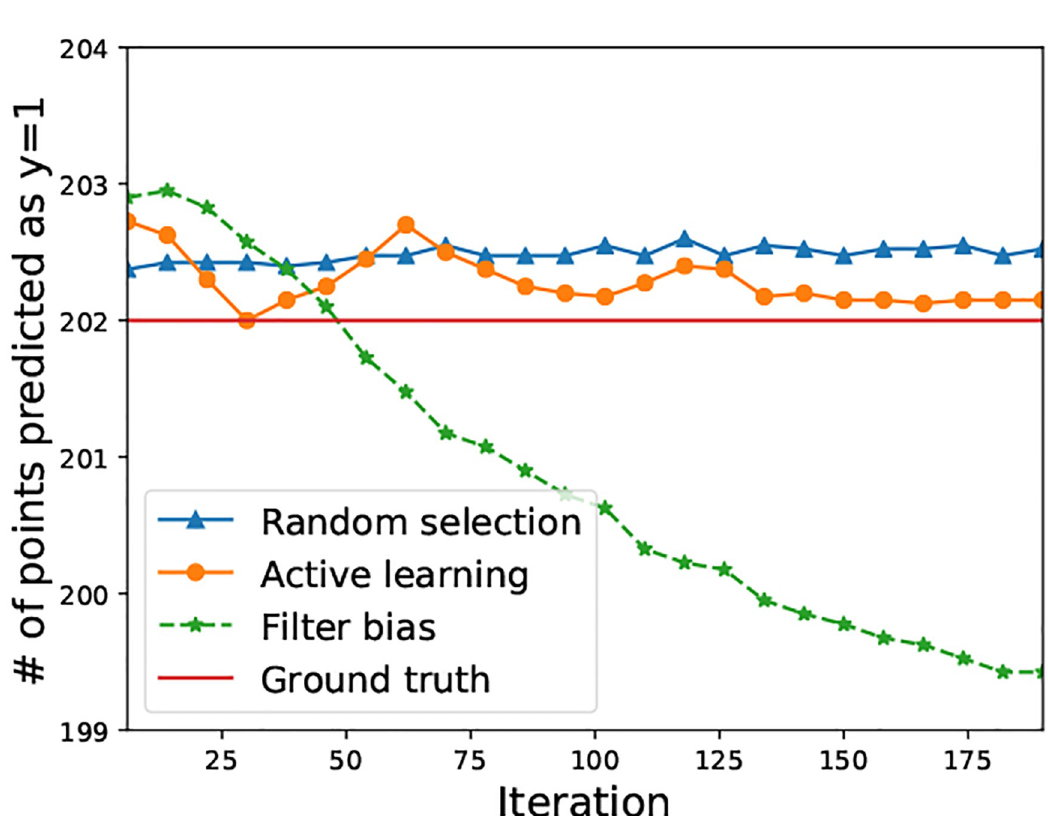
Fig 5. Boundary shift (Eq 18) based on the three iterated algorithmic bias forms. The y axis is the number of testing points which are predicted to be in class y = 1. This figure shows that random selection and active learning bias converge to the ground-truth boundary. Filter bias, on the other hand, results in decreasing numbers of points predicted in the target category class 1, consistent with an overly restrictive category boundary.